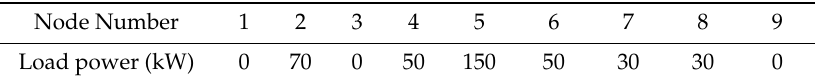
Table A2. Thermal power subsystem